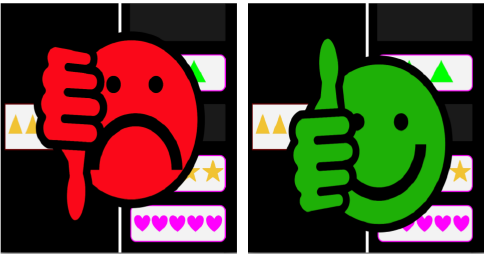
Figure 6. Feedback provided by the system after each user choice (Left: Negative - Right: